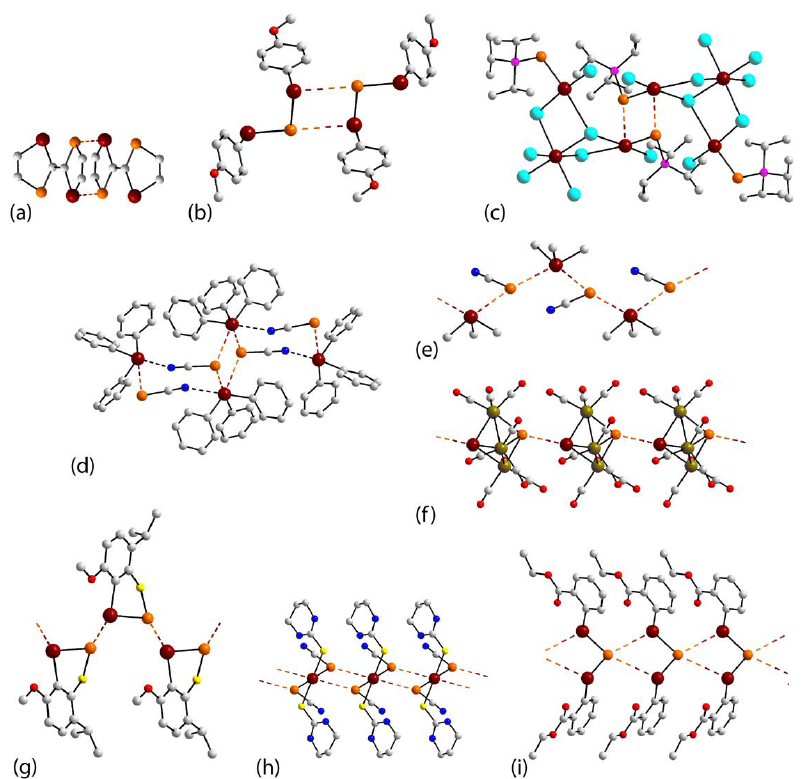
Figure 13. Supramolecular aggregation via Te … Se secondary bonding in (a) 42 {ECITEP; d(Te … Se) = 3.81 Å }, (b) 43 {BAWFUA; 3.68 Å }, (c) 46 {YIKFOO; 3.74 Å }, (d) 47 {ZZZAIJ01; 3.43, 3.44 & 3.54 Å },